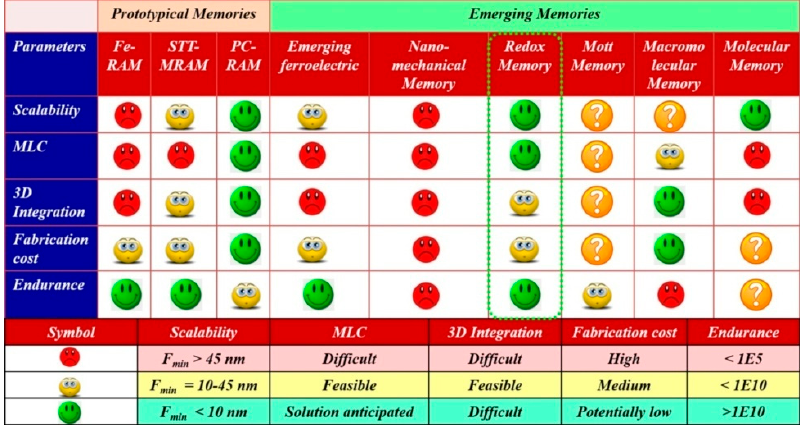
Figure 7. Performance comparison of prototype NVM and emerging NVM technologies [16].